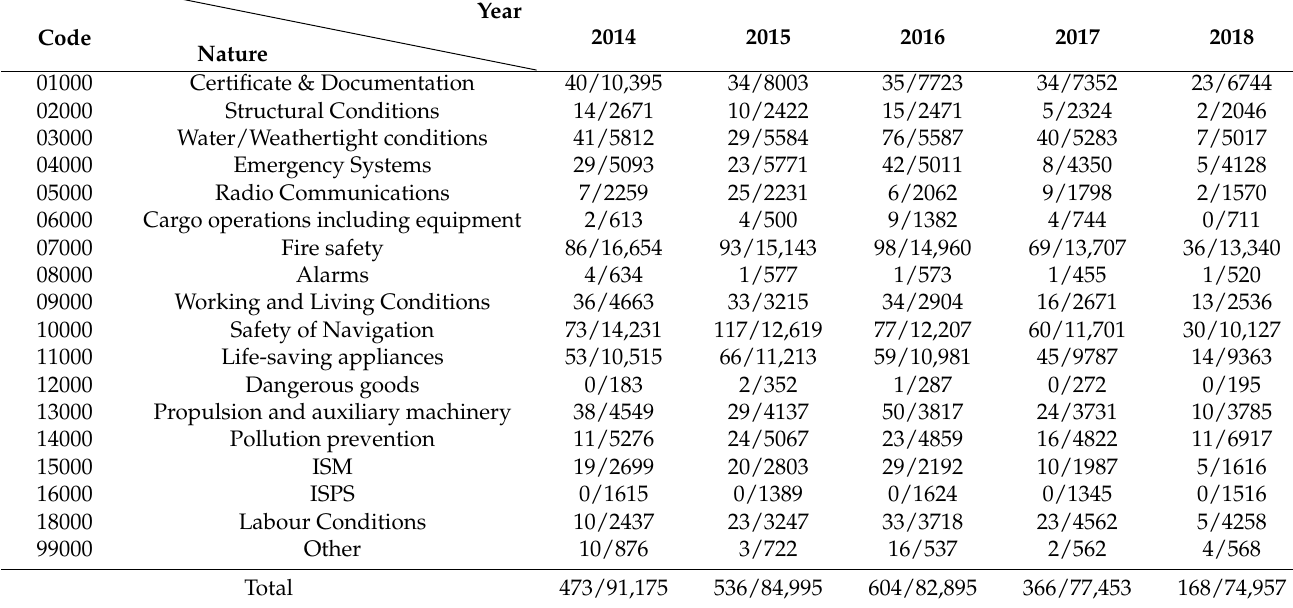
Table 6. Statistics on the deficiencies of ships in Taiwan and ships in the world in the Tokyo MoU from 2014 to 2018. Code